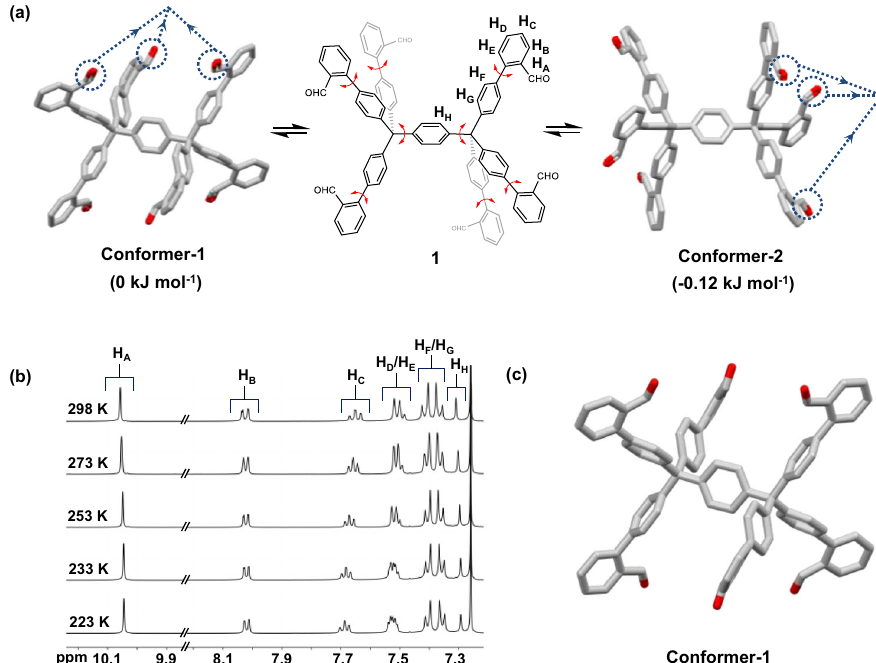
Fig. 2 Conformational interconversion of molecule 1 and its identi fi cation by NMR spectroscopy and SC-XRD. a Fast interconversion of Conformer-1 and -2 with extremely low isomerization barrier. Free energy of each isomer is determined by DFT calculation (B3LYP-D3 in PCM with chloroform as solvent). b Partial variable-temperature 1 H NMR spectra (500 MHz) of molecule 1 in CDCl 3 , showing rapid averaging of its possible conformers even at low temperature. The broadening of peaks of molecule 1 at low temperatures is due to its decreased solubility. c Molecular structure of molecule 1 revealed by SC-XRD, only able to identify Conformer-1 in solid-state. Solvent molecules and hydrogen atoms are omitted for clarity. Carbon atoms are labeled in gray, and oxygen in red. Dashed lines are used to facilitate the inspection of the orientation of formyl